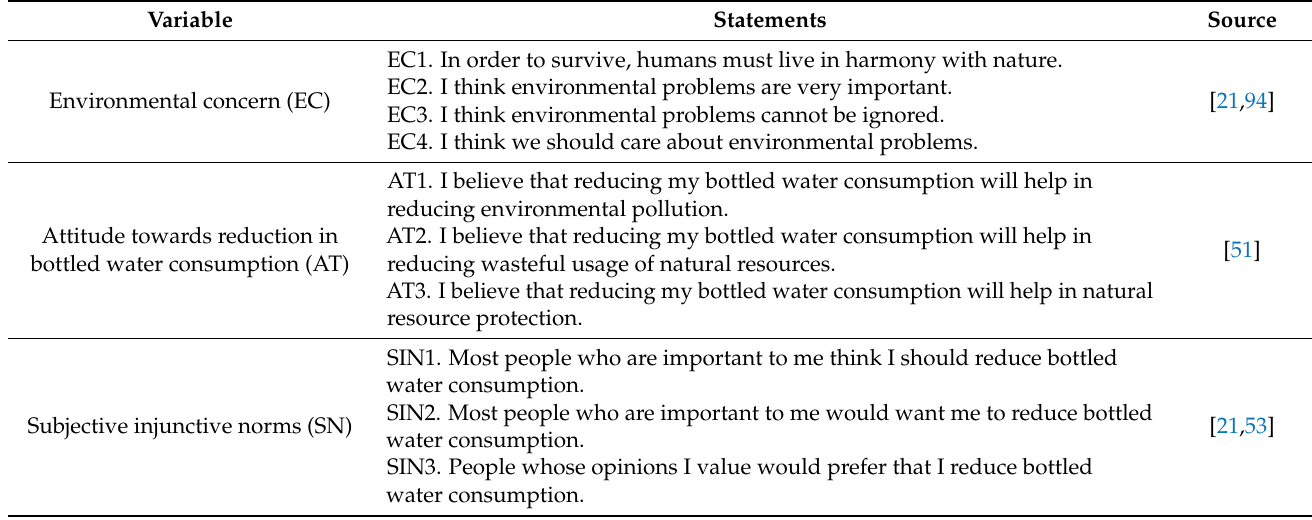
Table A1. Measurement scale construct used in the